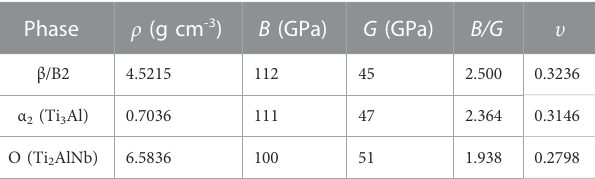
TABLE 2 Density ( ρ ) and elastic constants such as bulk modulus ( B ), shear modulus ( G ), B / G ratio, and Poisson ’ s ratio ( υ ) for β /B2, α 2 , and O phases (Pathak and Singh, 2015).